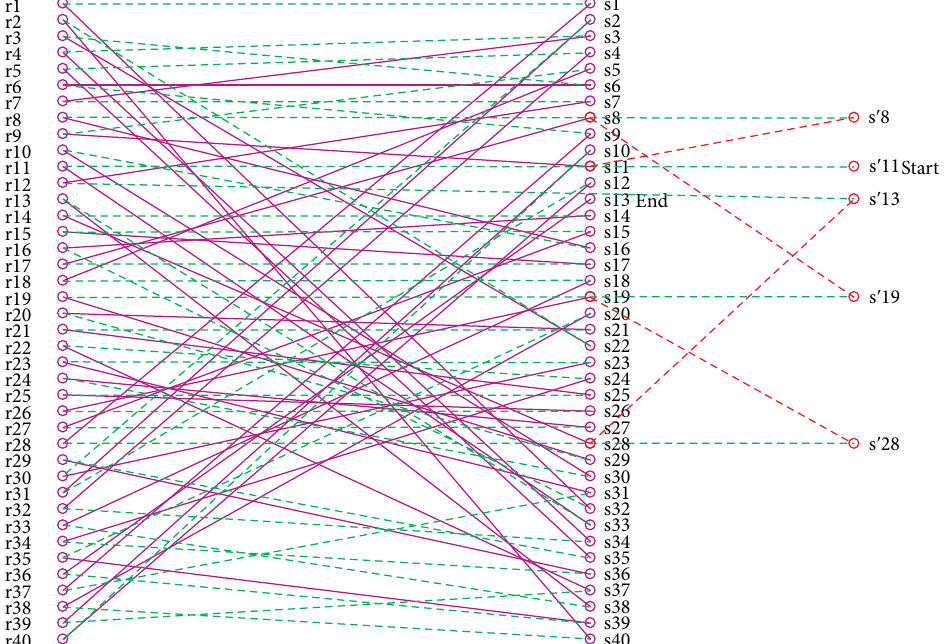
Figure 10: The gantry crane’s operation path for solution III. Table 8: The transshipment sequence for containers in solution III.